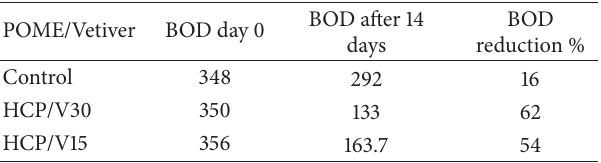
Table 3: Reduction of BOD in high concentration POME with different Vetiver